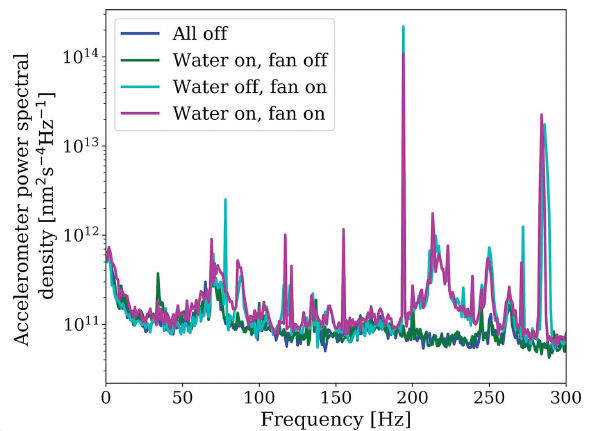
Figure 6 Vibration measurements collected at the diffraction detector under different operation conditions. The accelerometer power shows an increase at a frequency of 220 Hz related to the Pilatus fan operation.